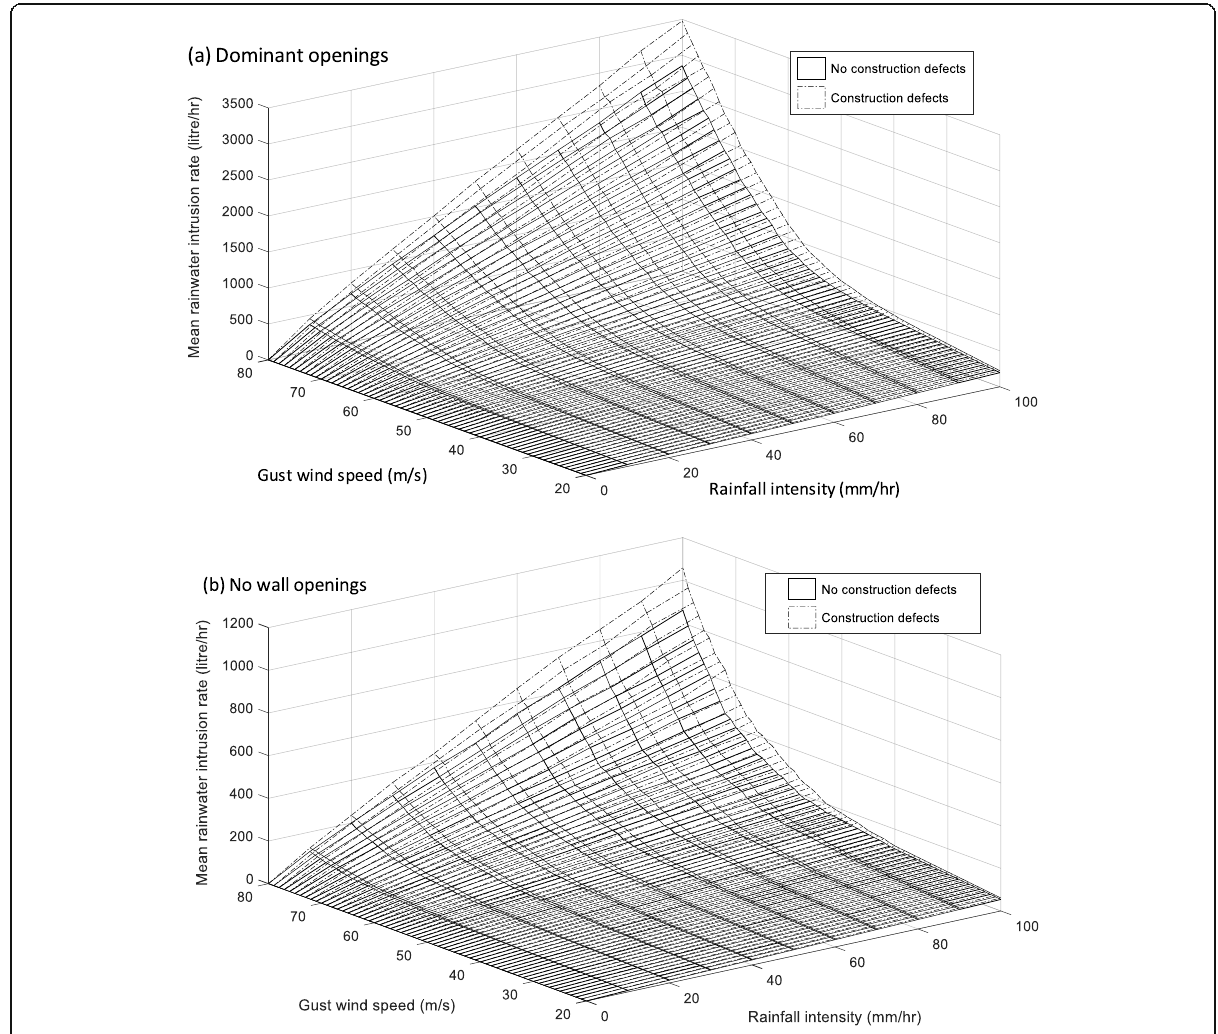
Fig. 7 Mean volumetric rate of rainwater intrusion with/without construction